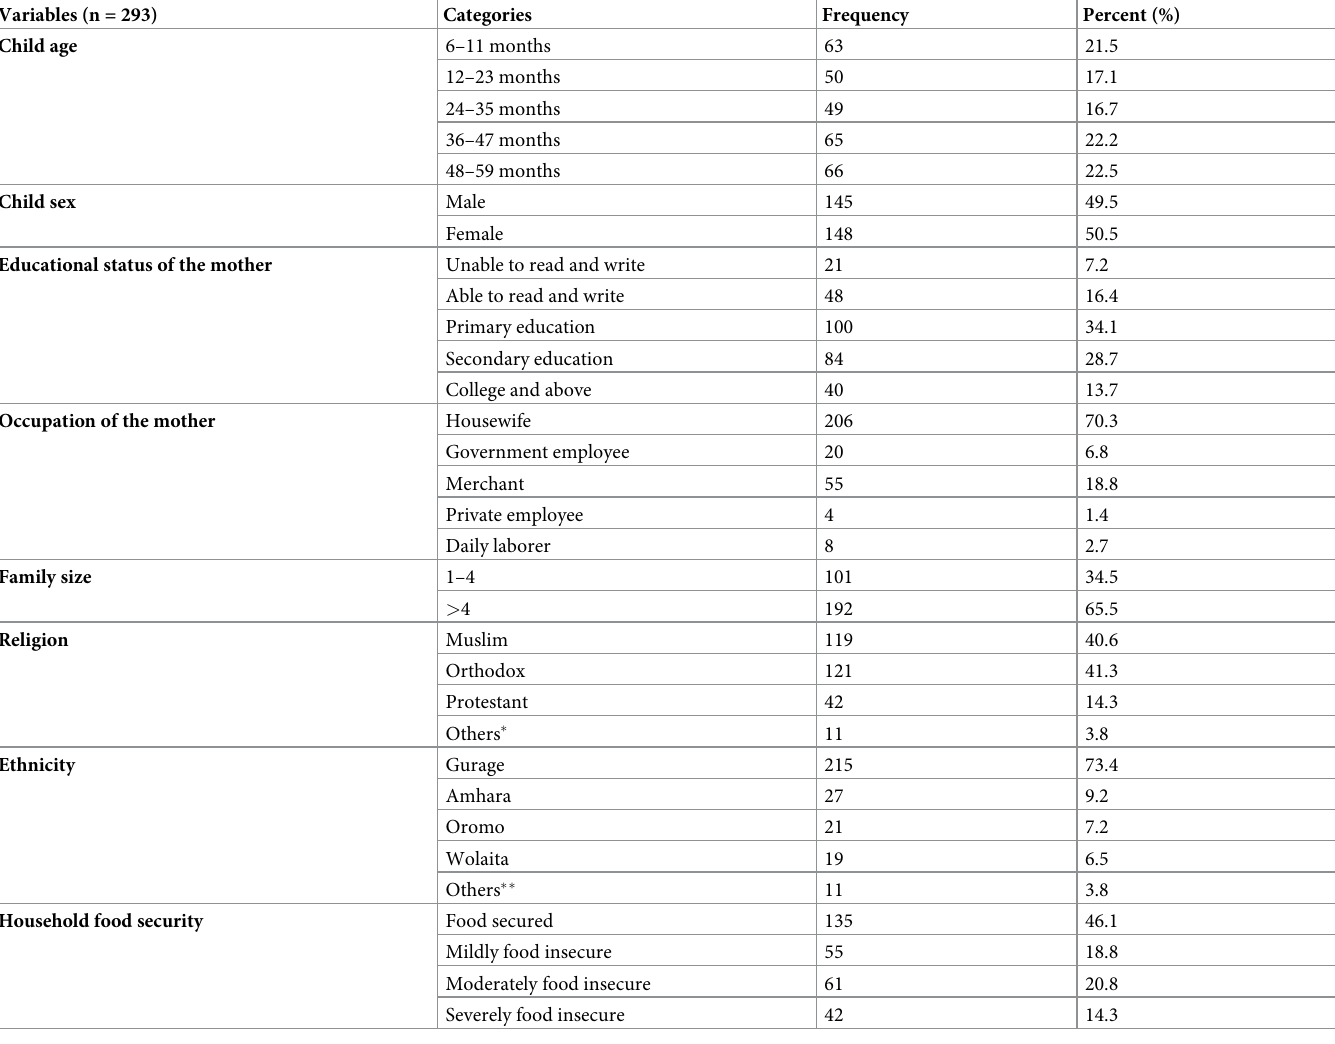
Table 1. Sociodemographic characteristics of study participants in Wolkite town,